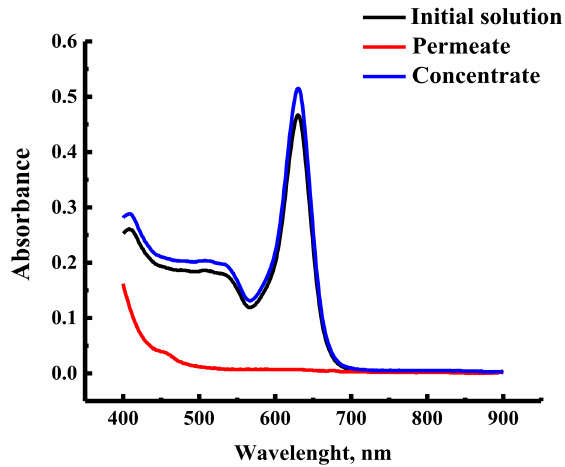
Figure 2. The spectra of the initial solution of caramel, permeate, and concentrate for the PIM-1